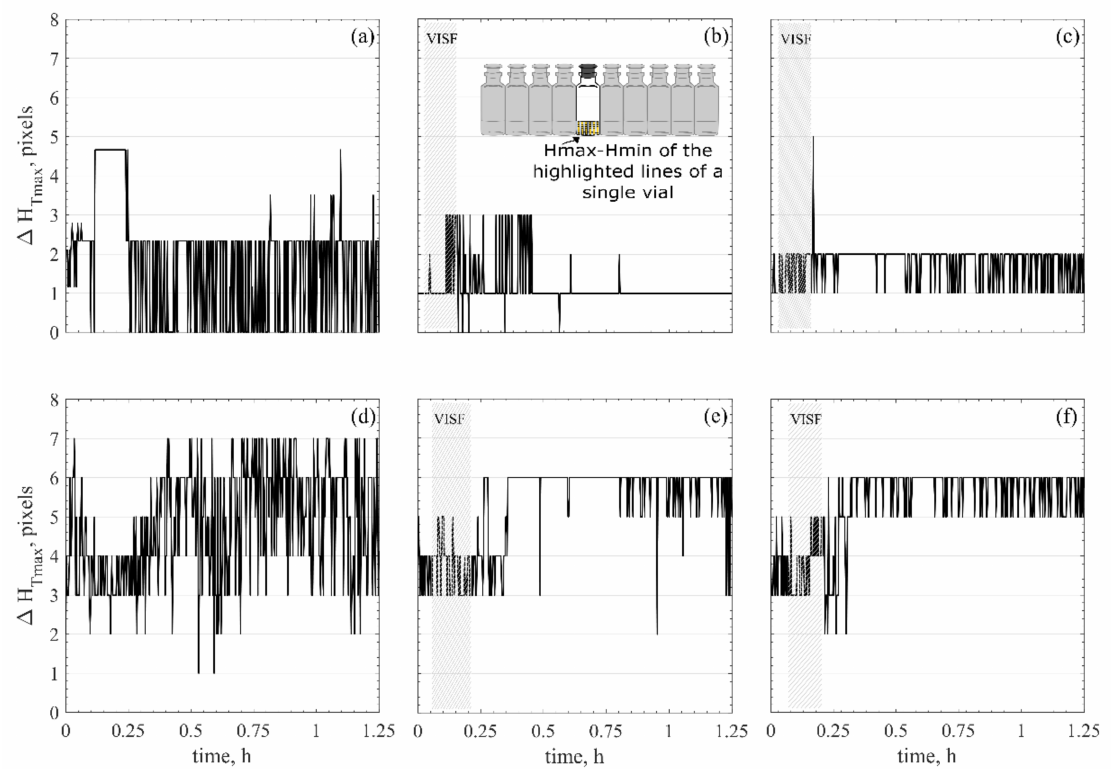
Figure A4. Range of measured H max profile values for a single vial for sucrose 5%. Top graphs ( a – c ) are ON-shelf, while bottom graphs ( d – f ) are OFF-shelf. ( a , d ) Spontaneous nucleation, ( b , e ) VISF 271 K, ( c , f ) VISF 263